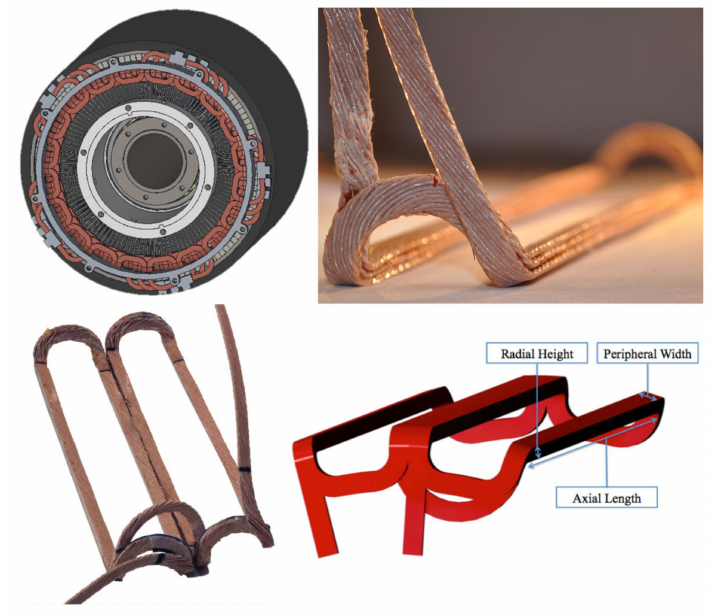
Figure 21. Rectangular shape formed, concentrated litz-wire windings for high-frequency electric machines